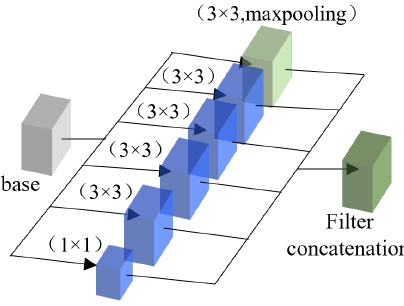
Figure 3. A PCB with k =